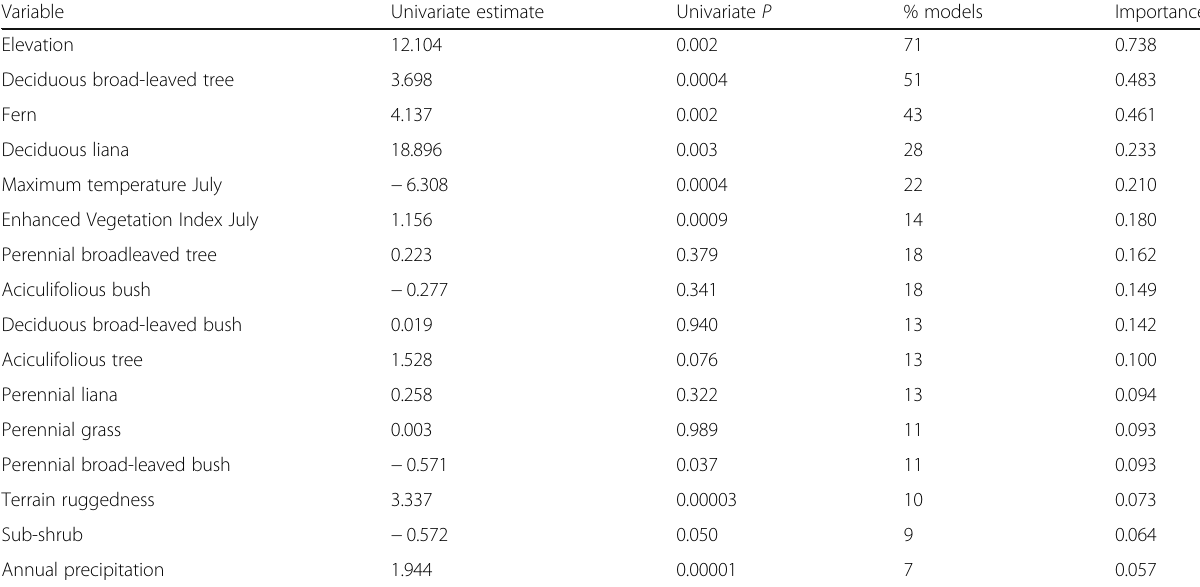
Table 2 Binomial generalized linear models results assessing the environmental variation between presence/absence sites. The model-averaged importance for the variables present in the 100 best models is shown. % models, percentage of candidate models where the variable was